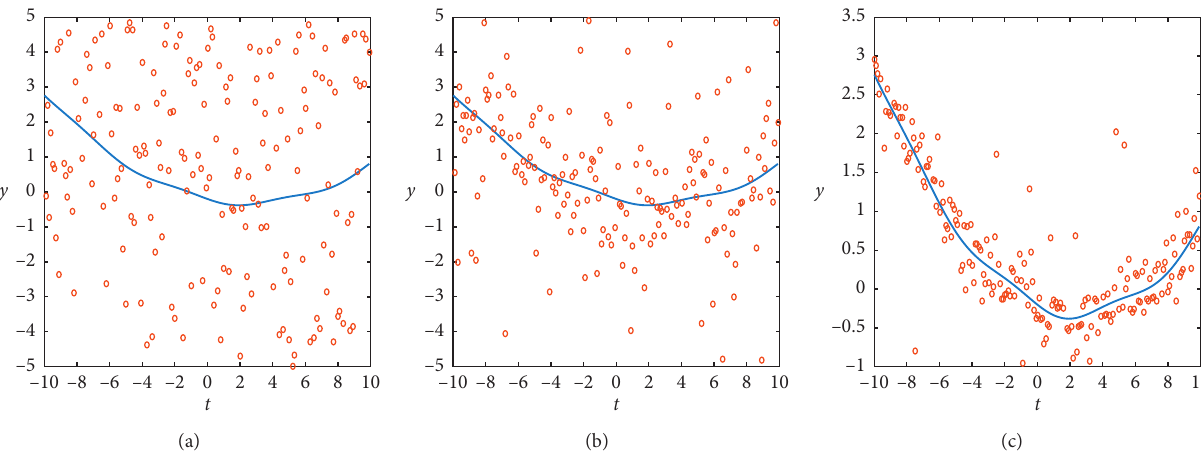
Figure 5: Generated signals with different noise types. The curves denote f ( t ; θ ) . The circles denote y ( t ) . (a) Uniform noise. (b) Cauchy noise. (c) Power-law noise. Table 3: Calibration performance for different noise types.